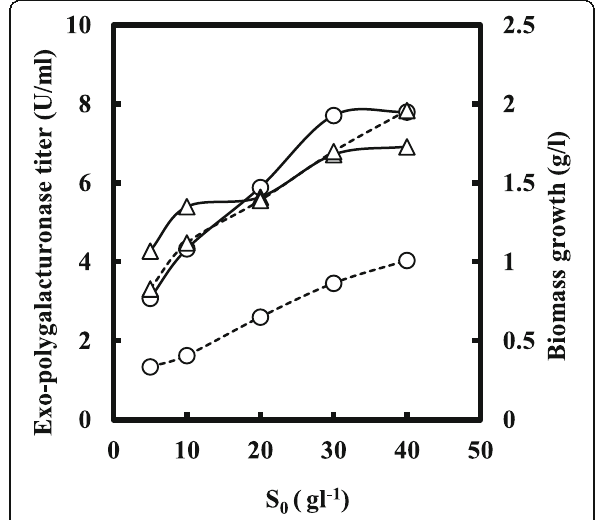
Fig. 1 Production trend of exo -polygalacturonase titer ( ○ ) and biomass ( Δ ) in submerged ( − ) and solid-state ( … ) fermentation of P. ostreatus for 7 days, with the varying initial level of carbon substrate (pomelo peel powder) in the culture medium. Data presented were the mean value of 3 sets of identical experiments (standard deviation was within